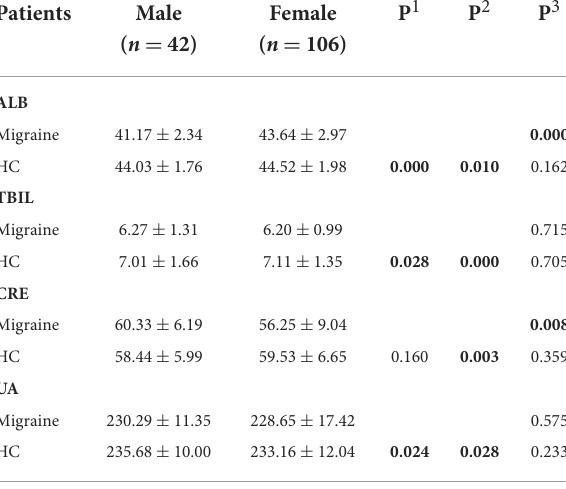
TABLE 4 Serum levels of ALB, TBIL, CRE, and UA in the migraine and HC groups.